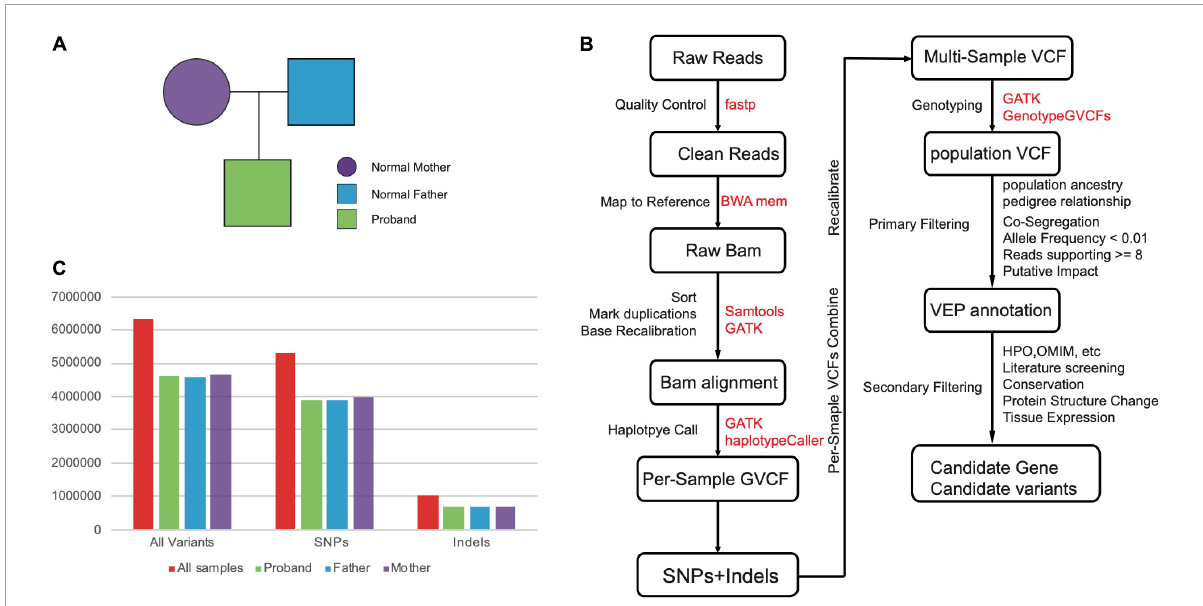
FIGURE1 (A) The pedigree of our samples. (B) The pipeline for the computational identification for candidate gene and variants. (C) The numbers of variants (SNPs and Indels) for our whole-genome sequenced samples.